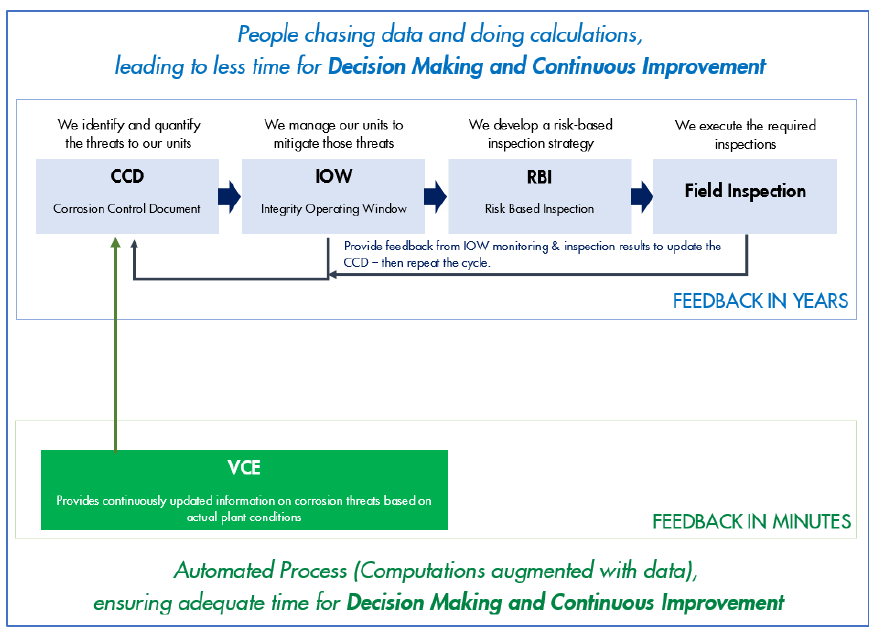
Figure 1. The corrosion and integrity management workflow, including the conventional feedback loop from inspections, together with faster feedback from the Virtual Corrosion Engineer.